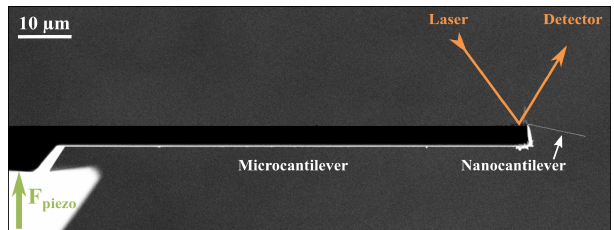
Figure 1. Example of a coupled sensor consisting of a micro- and a nanocantilever. The sensor is driven with a piezoelectric actuator, and the oscillation is detected with laser